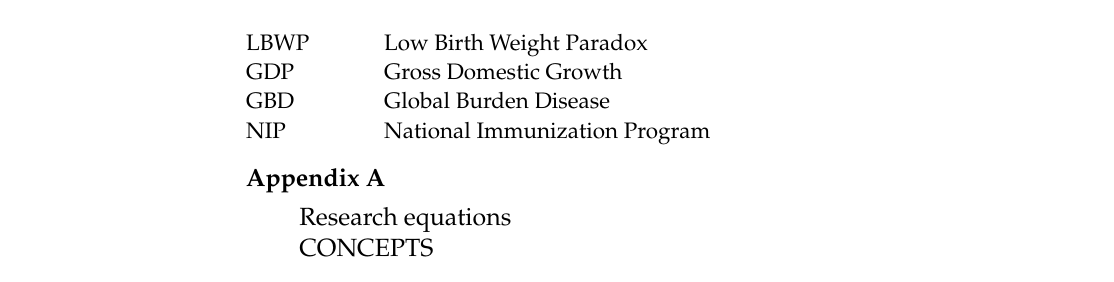
Table A1. Research question: What are the determinants of infant mortality in Brazil, from 2010 to